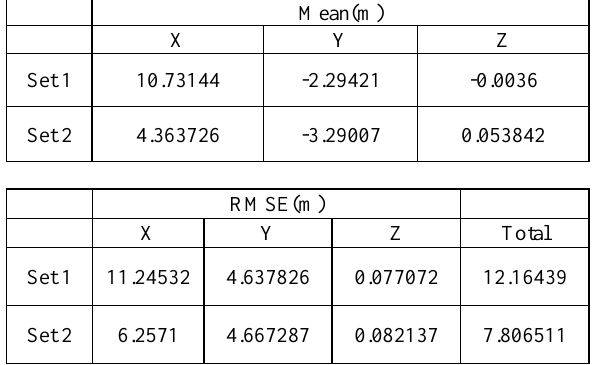
Table 2. Mean & RMSE using only smartphone sensor